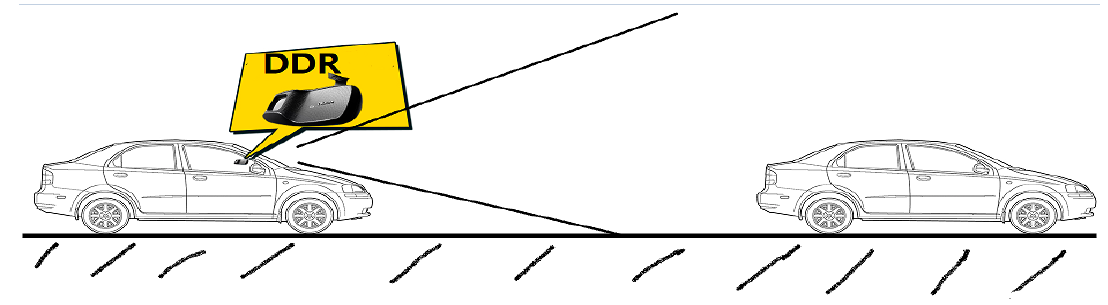
Figure 2. The structure of the proposed system: DDR (Driving Data Recorder) was placed in the vehicles.